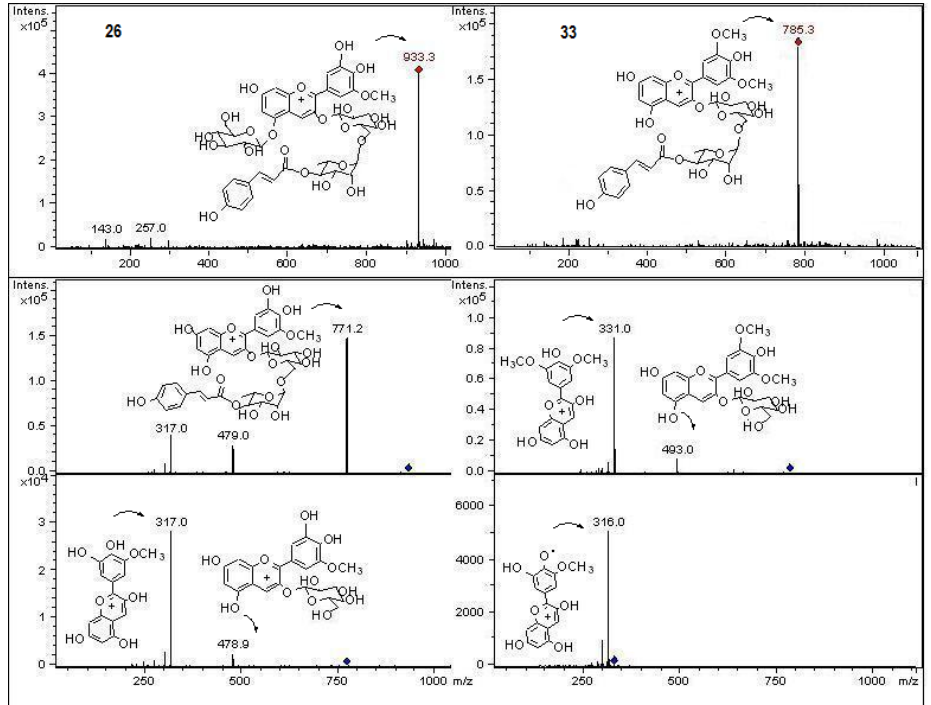
Figure 4. Structures, fragmentation, Full ESI-MS and MS-MS spectra of peaks 26 and 33